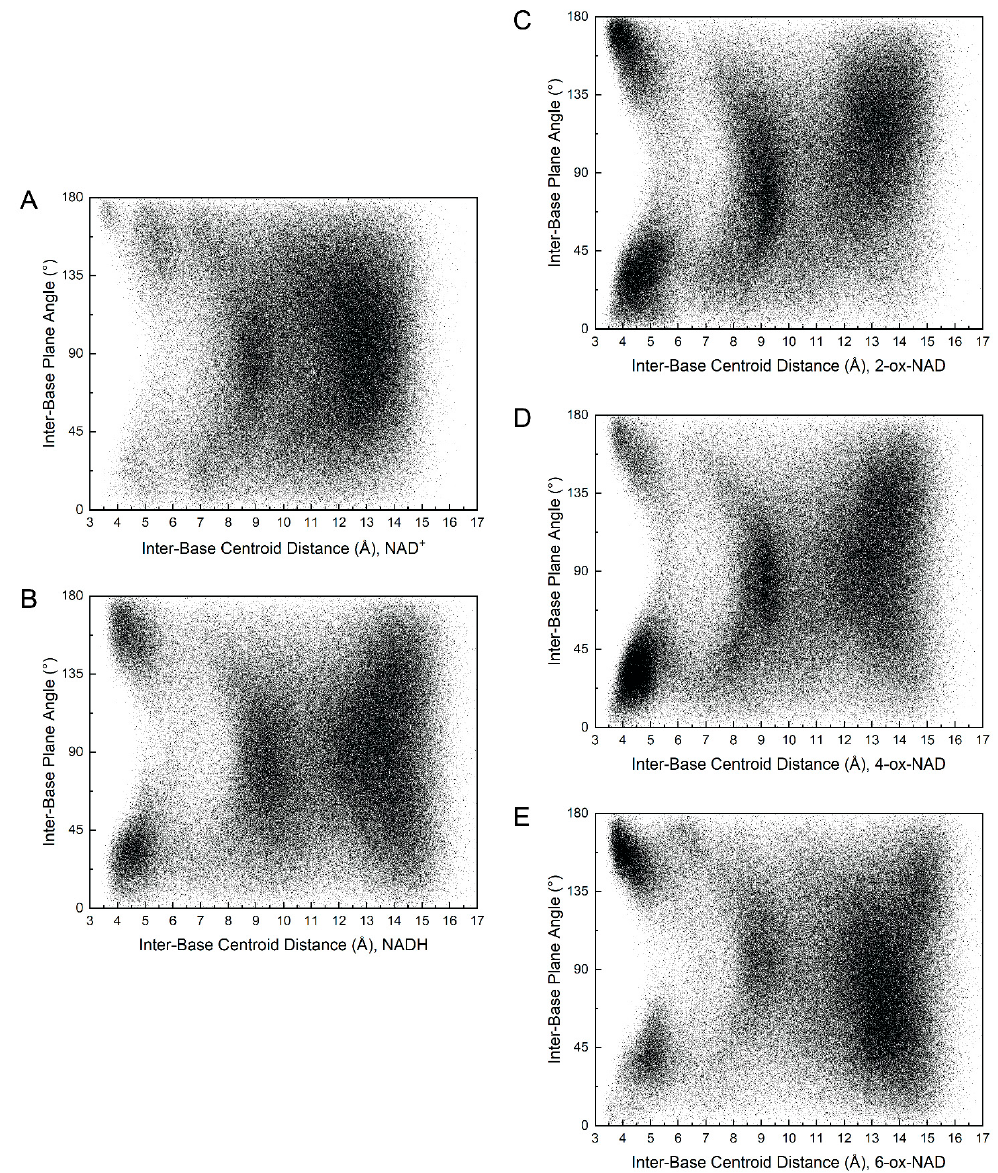
Figure 3. Scatter plot of the inter-base plane angle versus inter-base centroid–centroid distance for ( A ) NAD + , ( B ) NADH, ( C ) 2-ox-NAD, ( D ) 4-ox-NAD, and ( E ) 6-ox-NAD. The amide angle ( θ ) for NAD(H) also shows very distinct preferences. Two large populations near 0° and 180° are observed for NAD + (Figure 5B), whereas NADH strongly prefers θ near 0° (Figure 5B). Poses with θ near 0° are shown in Figure 4.